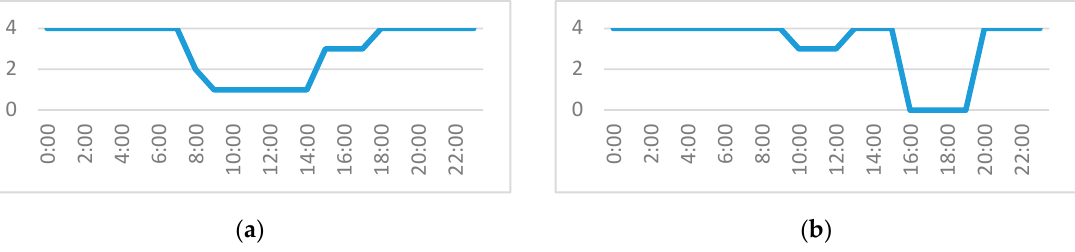
Figure 1. ( a ) Weekday occupancy profile; and, ( b ) Weekend occupancy profile.